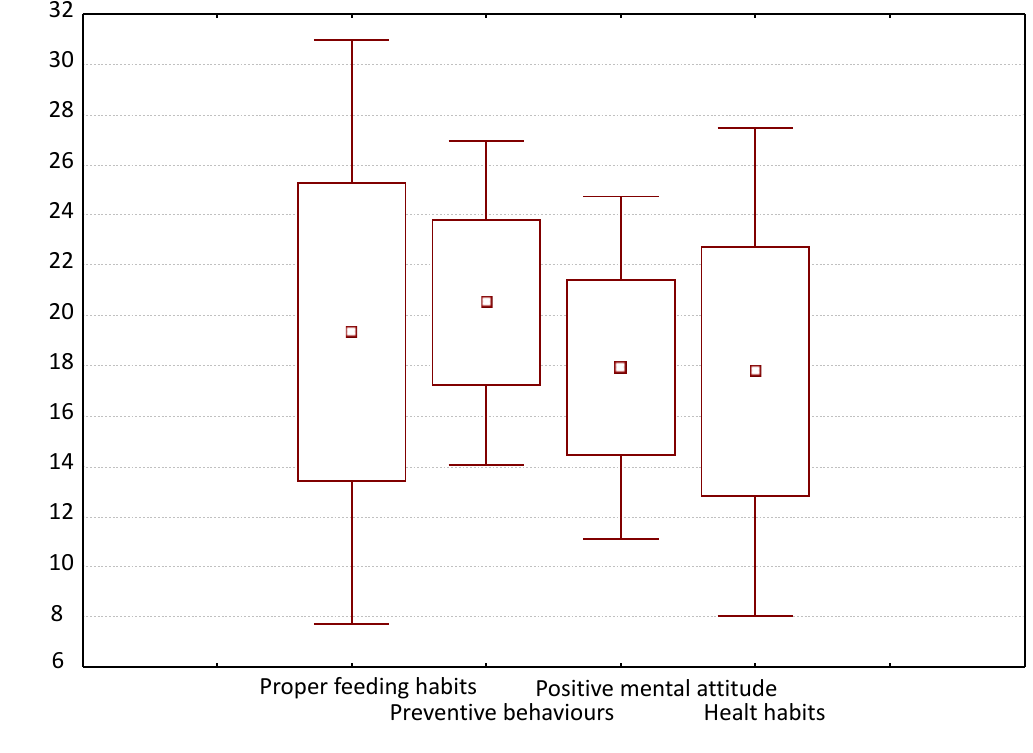
Figure1. The health-related behavior - descriptive analysis (Mean, Mean±SD, Mean±1.96 SD) Table 4. Healthy behaviours and feeling of personal competence - after K-Means clustering (cluster 1 and cluster 2). The table represents the result of cluster analysis with the use of K-Means Clustering: variance inside clusters.